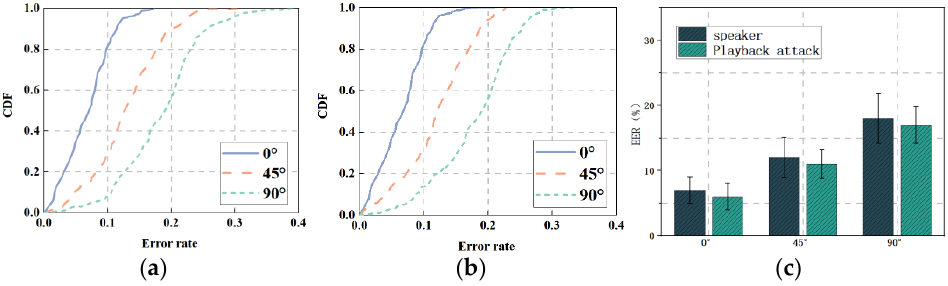
Figure 10. Different self − rotation angles: ( a ) CDFs (speaker); ( b ) CDFs (playback attack); ( c ) EER.